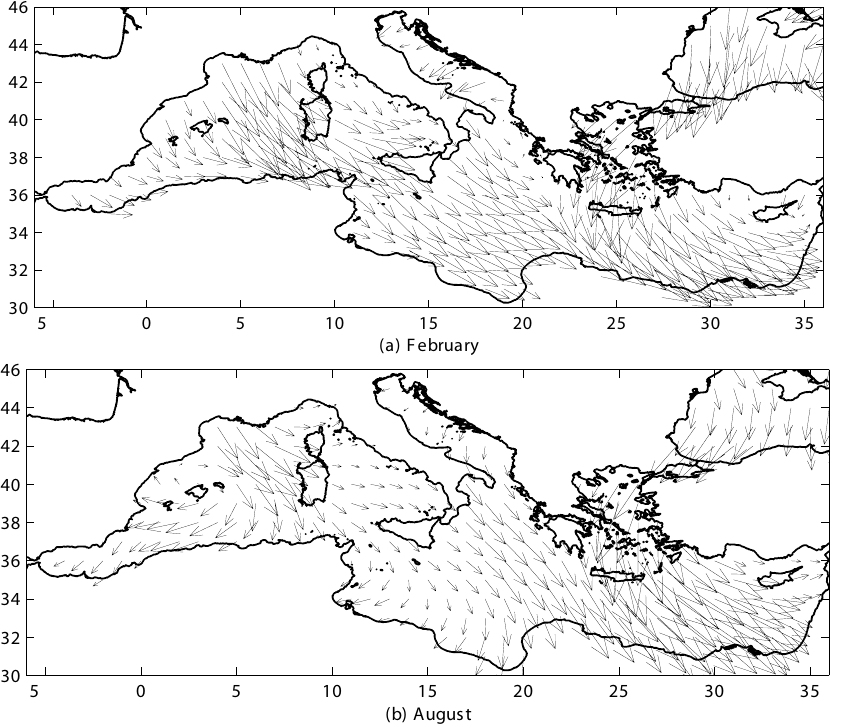
Fig. 1. (a) Wind stress field for Febru- ary (b) Wind stress field for